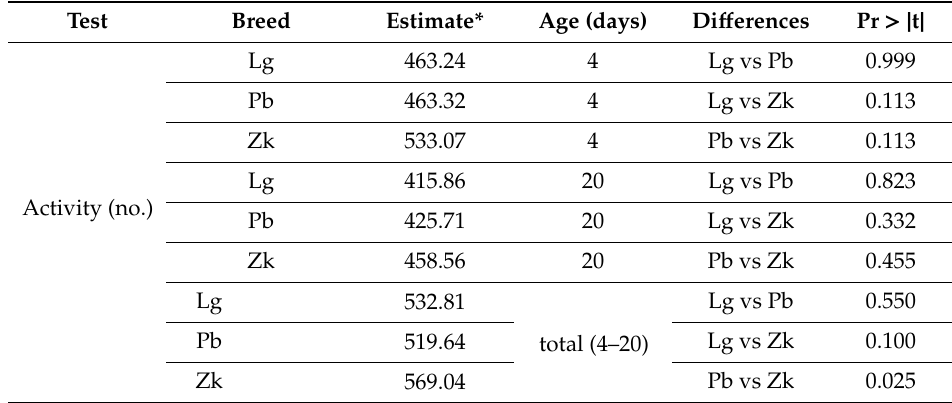
Table 4. Mean level of analysed indicators* and significance of di ff erences between the means in the Activity test in relation to the breed and age of